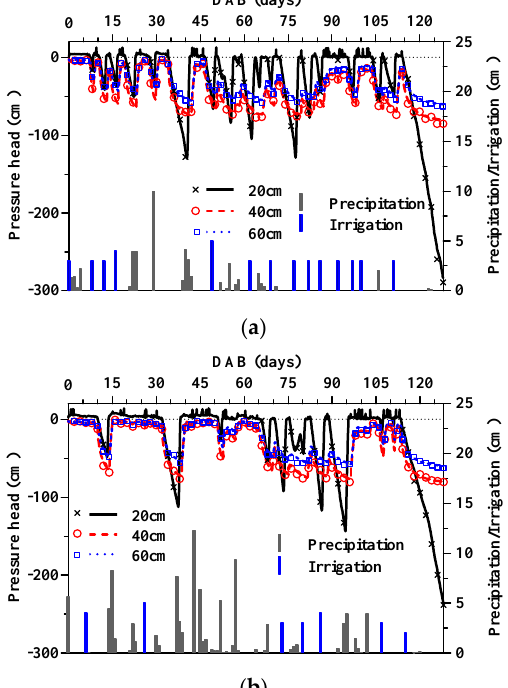
Figure 2. Simulated (lines) and observed (points) pressure heads at 20, 40, and 60 cm depths, and precipitation and irrigation water depths (vertical lines) during the ( a ) 2008 and ( b ) 2009 seasons. Positive pressure heads were not observed by tensiometers.